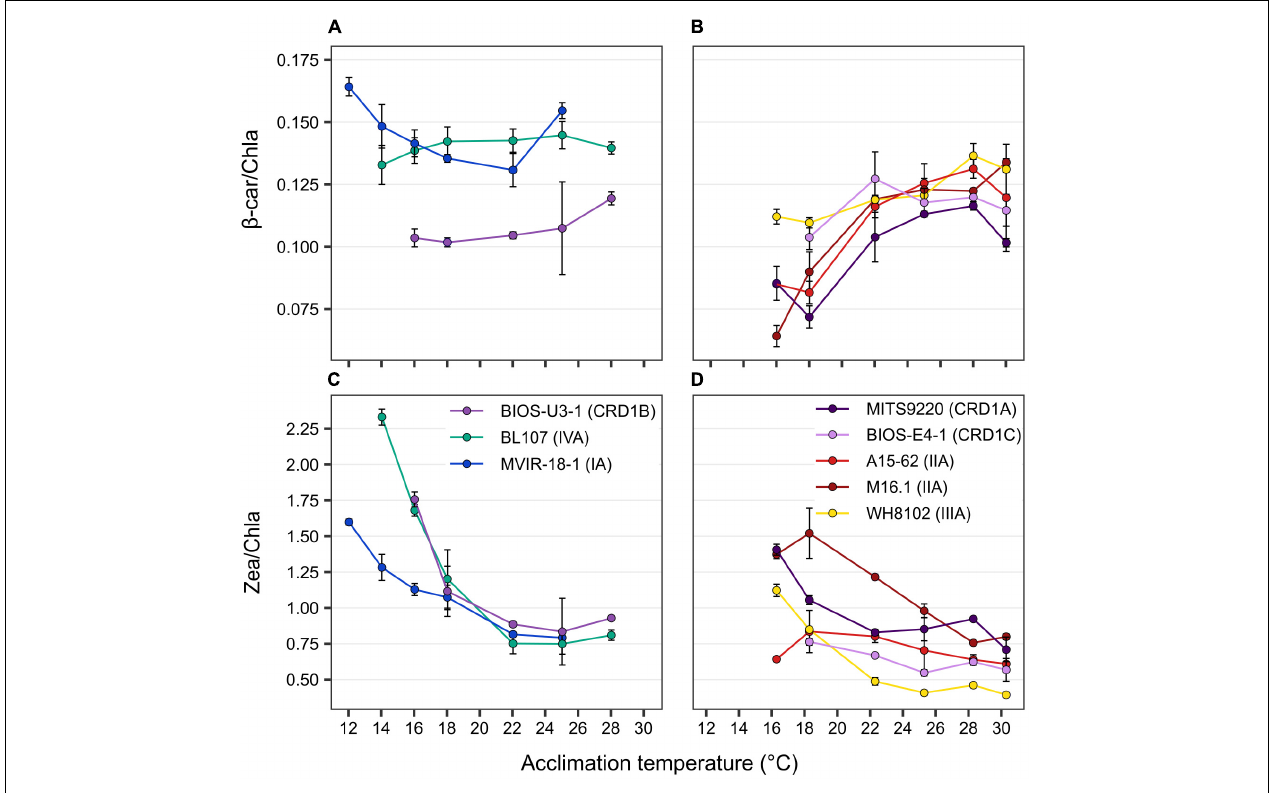
FIGURE 3 | Variation with growth temperature of cellular mass pigment ratios of CRD1 vs. clade I, II, III, and IV strains. (A,B) β -carotene ( β -car) to chlorophyll a (Chla) ratio. (C,D) Zeaxanthin (Zea) to Chl a ratio with (A,C) CRD1-B strain BIOS-U3-1 vs. cold thermotypes and (B,D) CRD1-A strain MITS9220 and the CRD1-C strain BIOS-E4-1 vs. warm thermotypes. Inserts indicate strain names and their corresponding ESTUs ( sensu Farrant et al., 2016) between brackets.